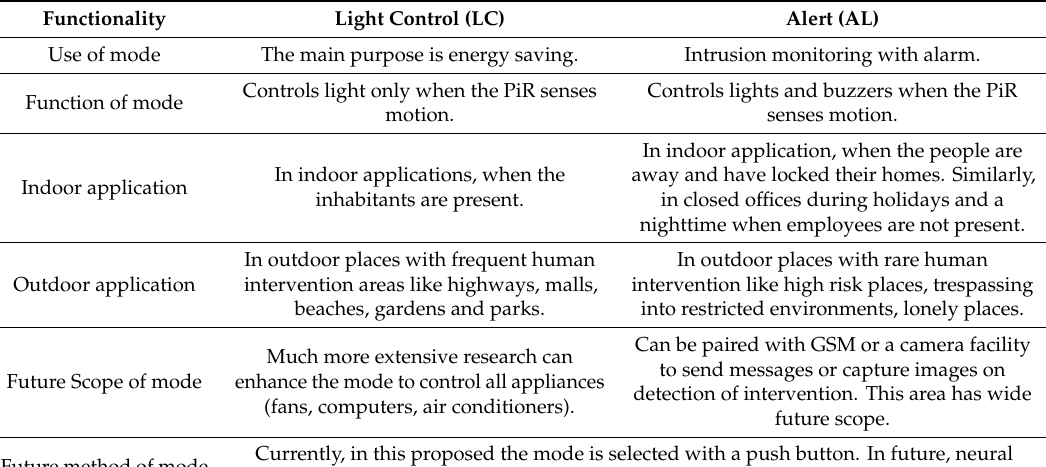
Table 3. Comparison of two modes.